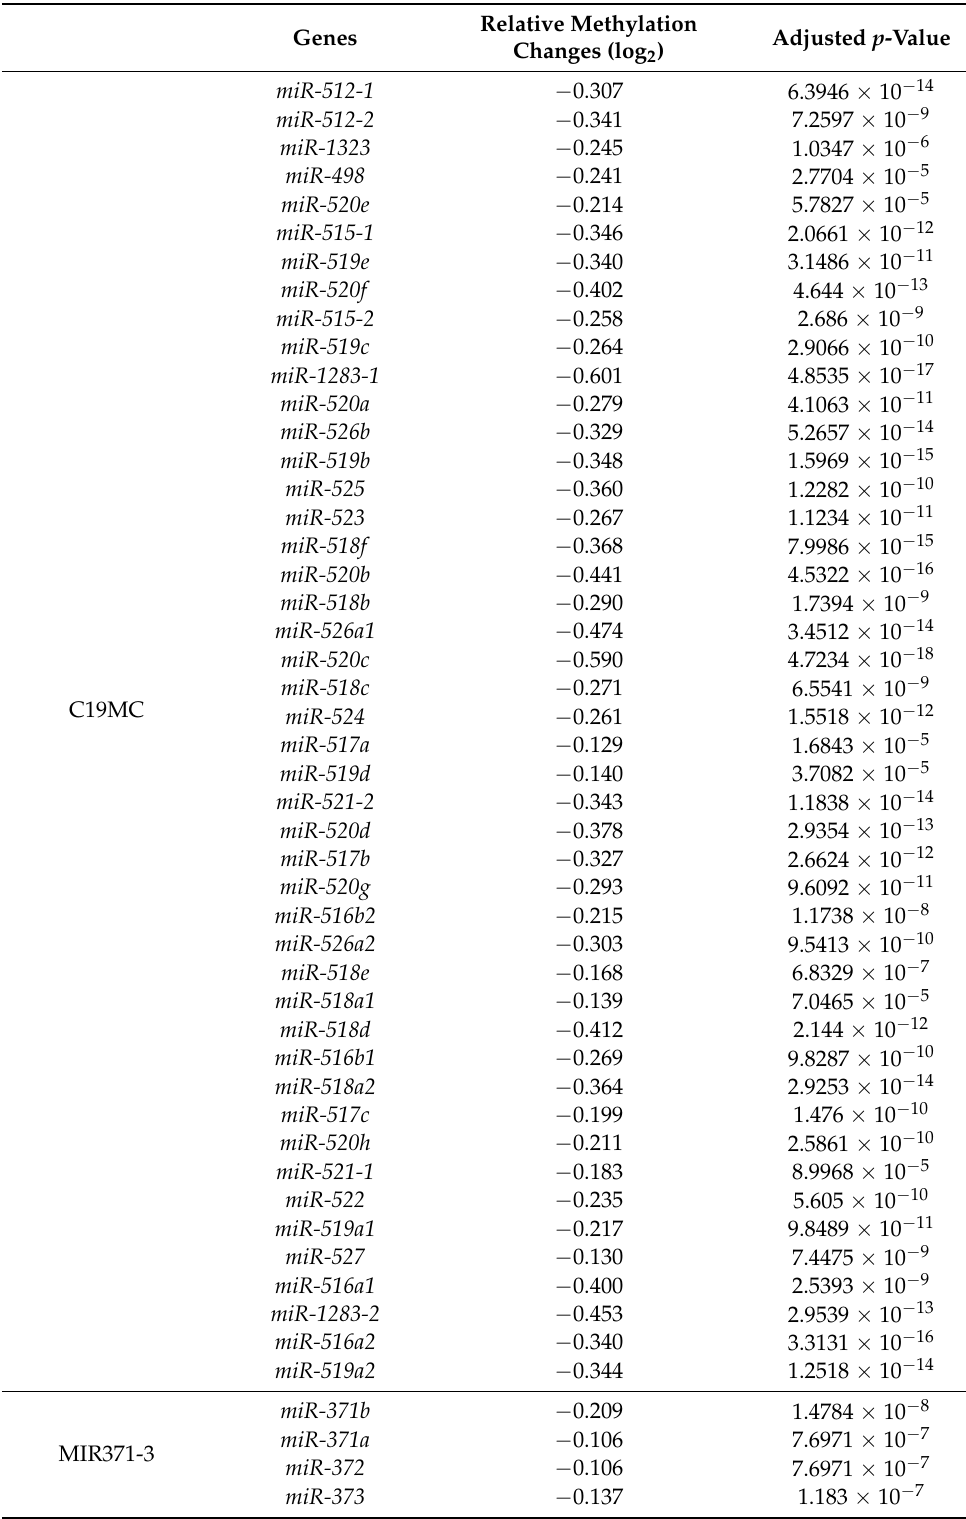
Table 1. Statistically differences of the methylation levels of C19MC and MIR371-3 clusters between human lung tumor samples and normal